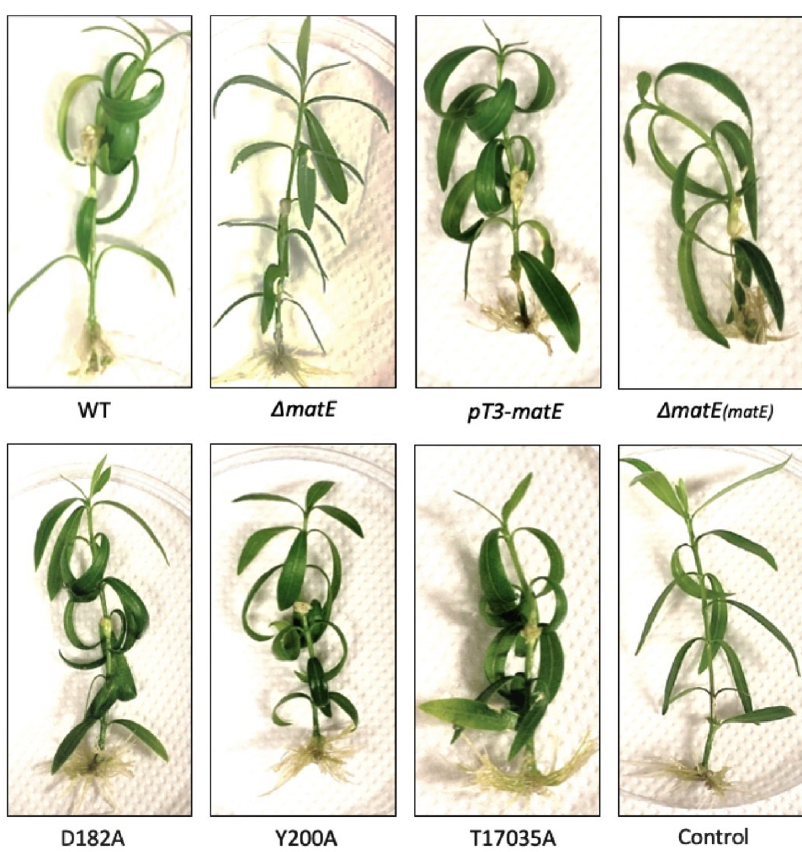
Figure 5. Hyperplastic symptoms obtained at 21 dpi in pathogenicity tests carried out on micropropagated oleander plants with Psn23 wild type and its mutants ∆ matE , pT3 -matE , D182A, Y200A, and T17035A. Control: sterile physiological solution (SPS, NaCl 0.85%) inoculated plants. Complemented mutant for ∆ matE : ∆ matE ( matE